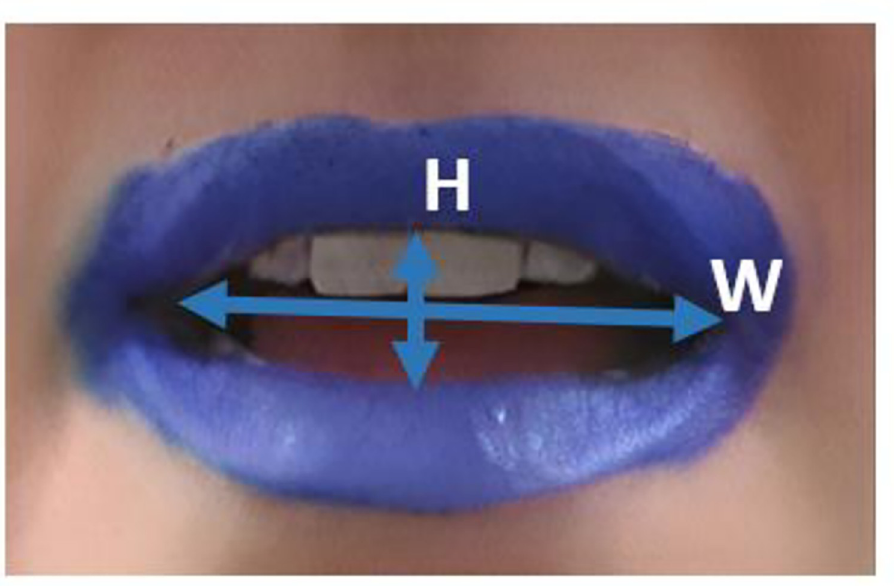
In order to reduce the length of the perceptual experiment, three repetitions of each vowel produced by each speaker were selected: the fourth, fifth and sixth repetitions. Several mea- sures were extracted on the audio and video signals to characterize the stimuli. As can be seen on the schematic representation provided in Fig 1, two measures were semi-automatically extracted from the image corresponding to vowel midpoint using custom-made Matlab pro- grams: interolabial lip width, corresponding to the distance, in pixels, between the left and